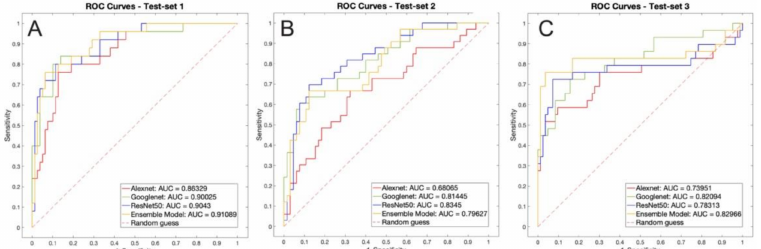
Figure 9. ROC analysis of the three test sets. ( A ) test set 1, ISIC images; ( B ) test set 2, new dermato- scopic images; ( C ) test set 3, Nurugo TM images.